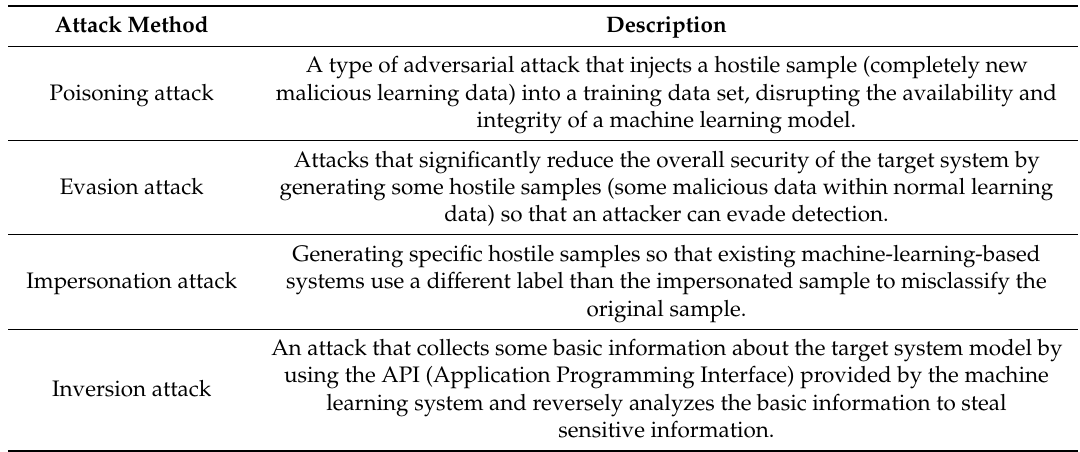
Table 1. Attack techniques applicable to